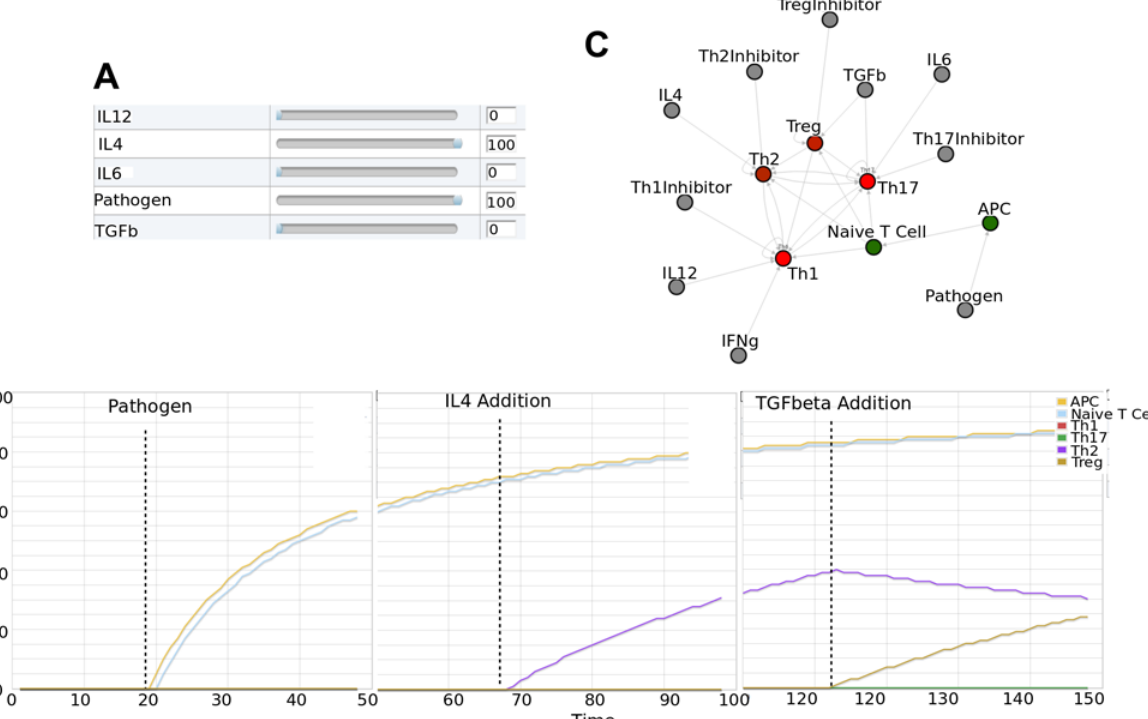
Fig 3. Interactive simulation of a T cell differentiation model. A) Simple sliders can be used to change the activity levels of various stimuli. B) Example of an interactive, real-time simulation. Left: Activation of Pathogen results in the stimulation of Antigen Presenting Cells and Naive T Cells. Middle: Stimulation with IL4 results in the activation of Th2 cells. Right: Addition of TGF beta stimulates Tregs, resulting in the suppression of Th2 cells. C) Network view of the changing dynamics during a real-time simulation. (Color range from bright red [inactive components] to bright green, which denotes full activity.)